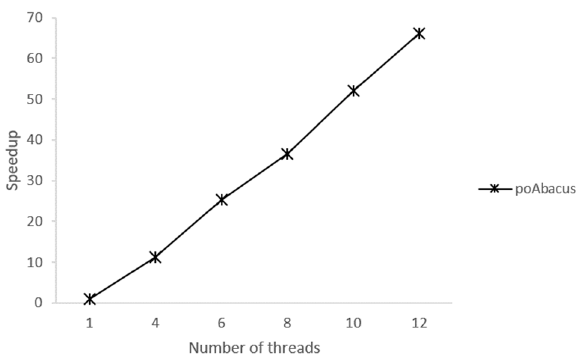
Figure 8. Speedup of poAbacus over Abacus.